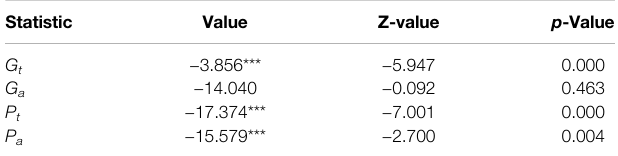
TABLE 6 | Westerlund cointegration test results.